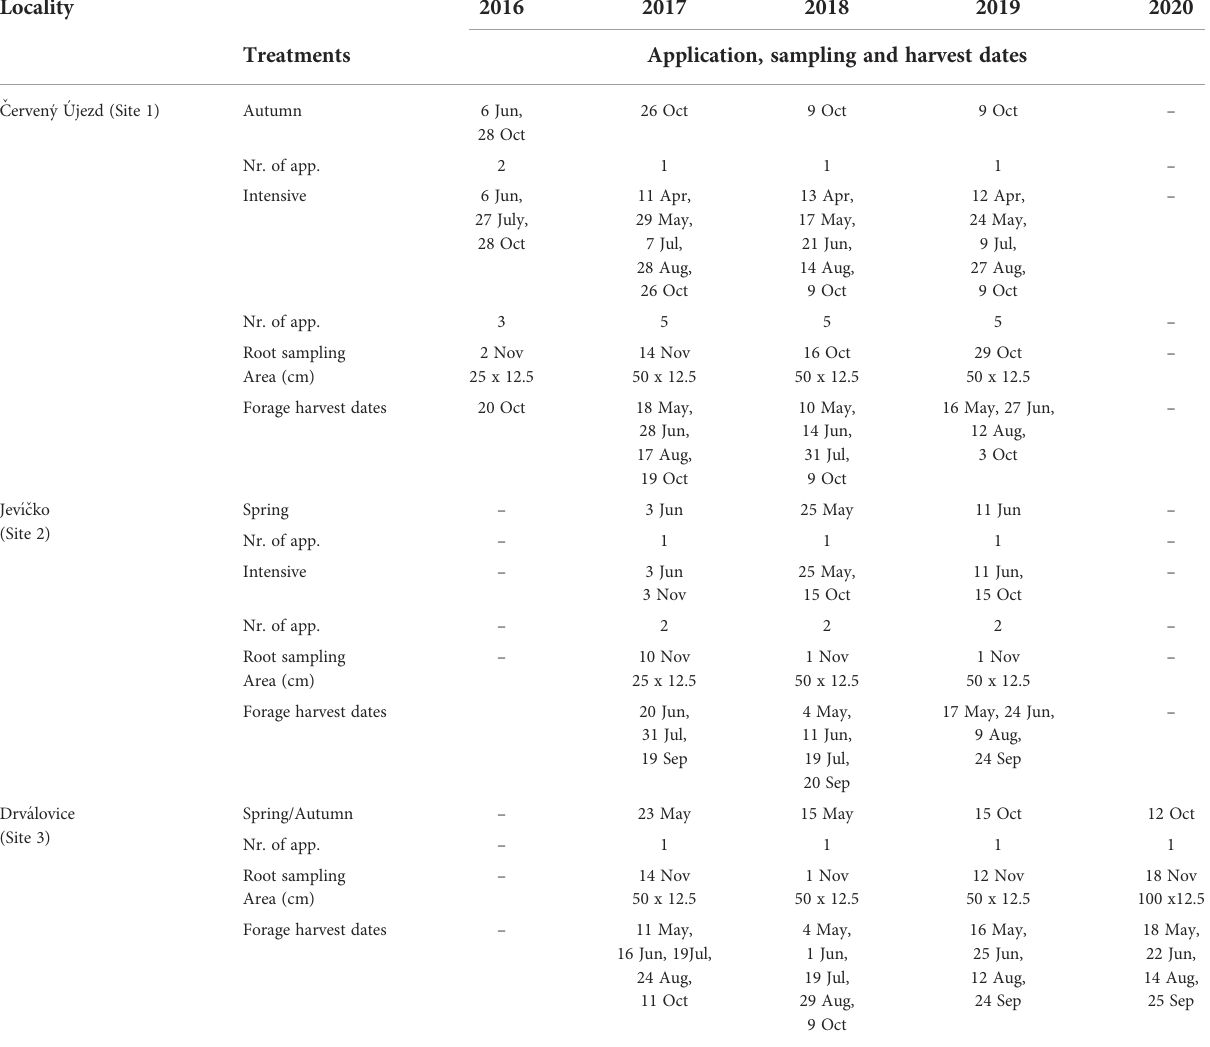
TABLE 2 Description of treatments, application dates of Polyversum at a dose rate of 100 g ha -1 in Polyversum treatments together with root sampling area and sampling dates, and forage harvest dates for all treatments in the years of the study.